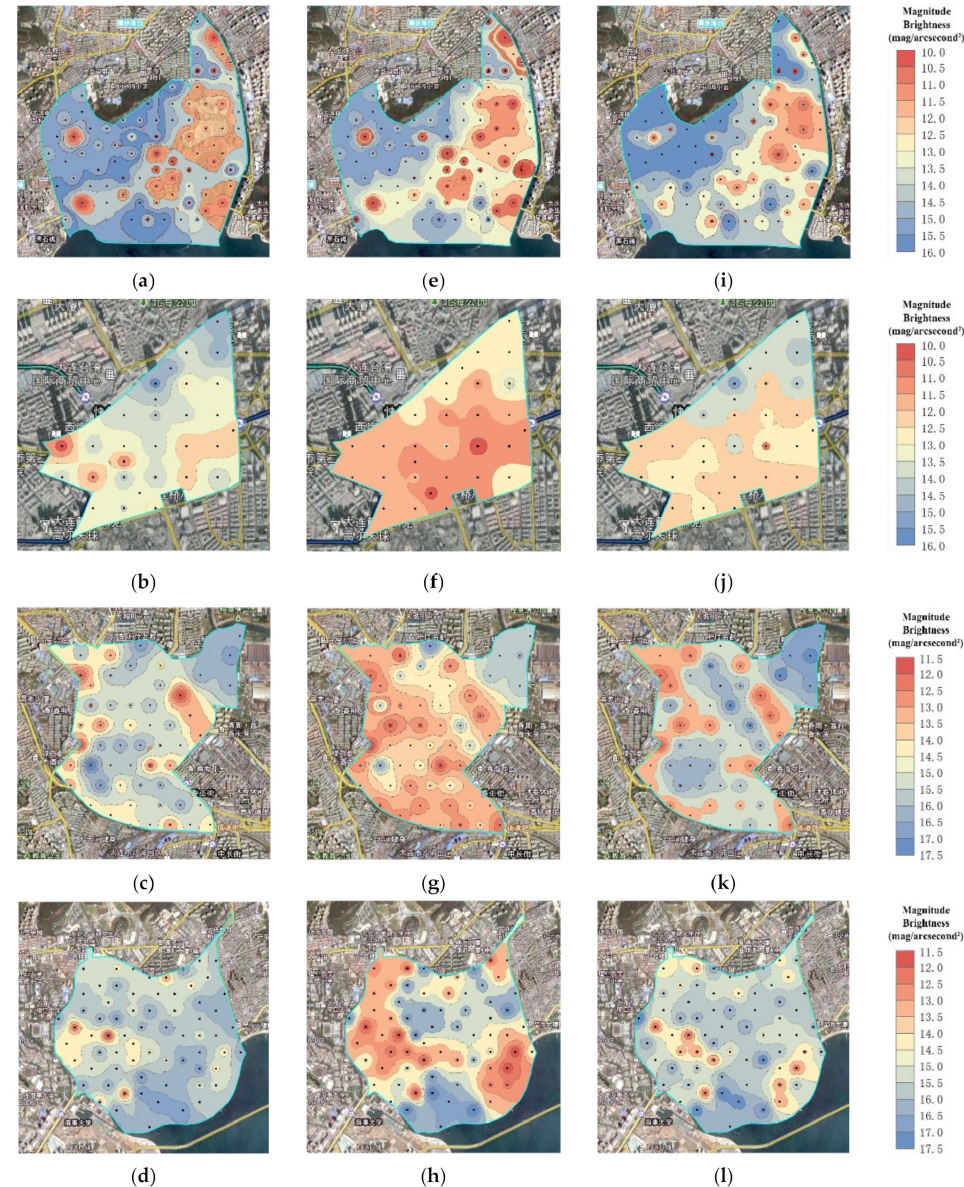
Figure 10. Magnitude brightness distribution in three directions of high value area. ( a ) Xinghaiwan upper window; ( b ) Qingniwa upper window; ( c ) Chunliu upper window; ( d ) Heishijiao upper window; ( e ) Xinghaiwan horizontal window; ( f ) Qingniwa horizontal window; ( g ) Chunliu horizontal window; ( h ) Heishijiao horizontal window; ( i ) Xinghaiwan lower window; ( j ) Qingniwa lower window; ( k ) Chunliu lower window; ( l ) Heishijiao lower